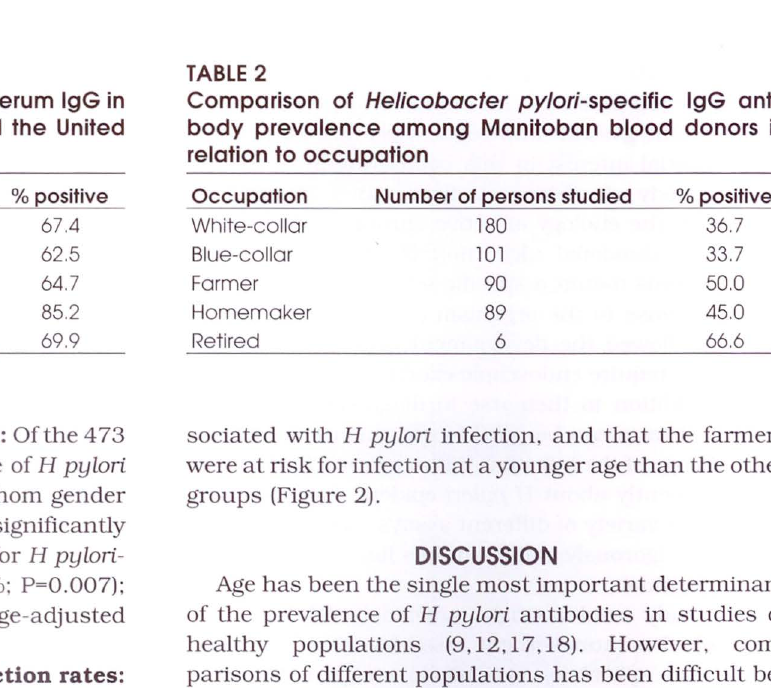
Comparison of He/icobacter pylori-specific lgG anti body prevalence among Manitoban blood donors